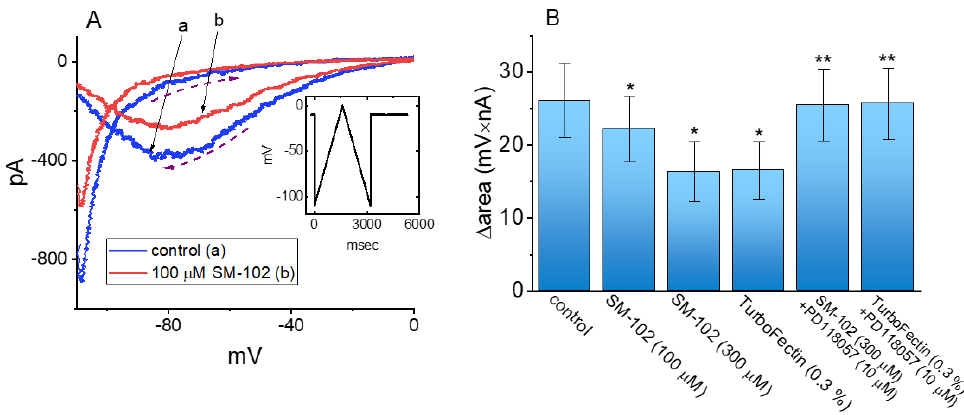
Figure 4. Effect of SM-102 on voltage-dependent hysteresis of I K(erg) identified in GH 3 cells. In this set of experiments, as whole-cell configuration was firmly established (i.e., membrane rupture after suction), we applied an isosceles-triangular ramp pulse to the examined cells. Inset indicates the voltage-clamp protocol used. ( A ) Representative instantaneous I–V relationship of I K(erg) evoked by such triangular ramp pulse. a: control (i.e., SM-102 was not present); b: in the presence of 100 µ M SM-102. The dashed arrows indicate the current trajectory which time passed over. ( B ) Summary bar graph showing effects of SM-102, TurboFectin TM , SM-102 plus PD118057 and TurboFectin TM plus PD118057 on the hysteretic area (i.e., ∆ area) of I K(erg) elicited in response to long isosceles triangular ramp pulse (mean ± SEM; n = 8 for each bar). Data analysis was performed by ANOVA-1 ( p < 0.05). * Significantly different from control ( p < 0.05) and ** significantly different from SM-102 (300 µ M) alone group ( p < 0.05). As denoted by the dashed arrows in Figure 4, from a difference in the area (i.e.,